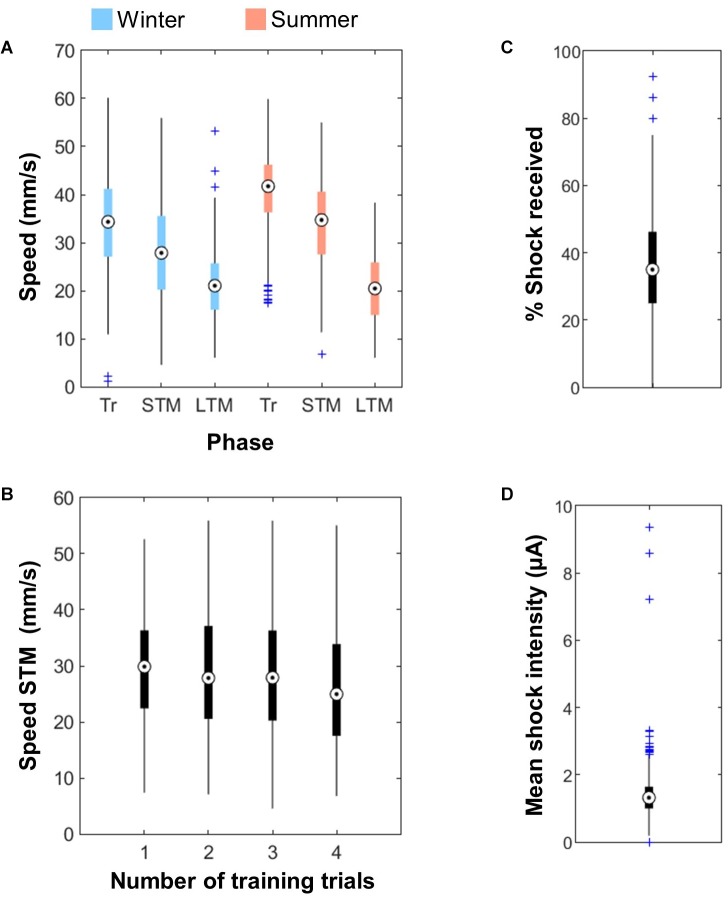
Walking speed and shocks. (A) Walking speed of the bees during the training phase (Tr), the STM test and the LTM test. Summer bees (n = 576 for Tr + STM, 288 for LTM) were slightly faster than bees reared under artificial conditions during winter (n = 640). The bees’ speed also depended on the phase considered. (B) The walking speed of the bees during the STM test was slightly reduced after 4 training trials (n = 640). (C) Around 35% of the shocks delivered were actually received by the bees (n = 1216 bees). (D) Intensity of the shocks received by the bees (mean for each individual bee, n = 1216).